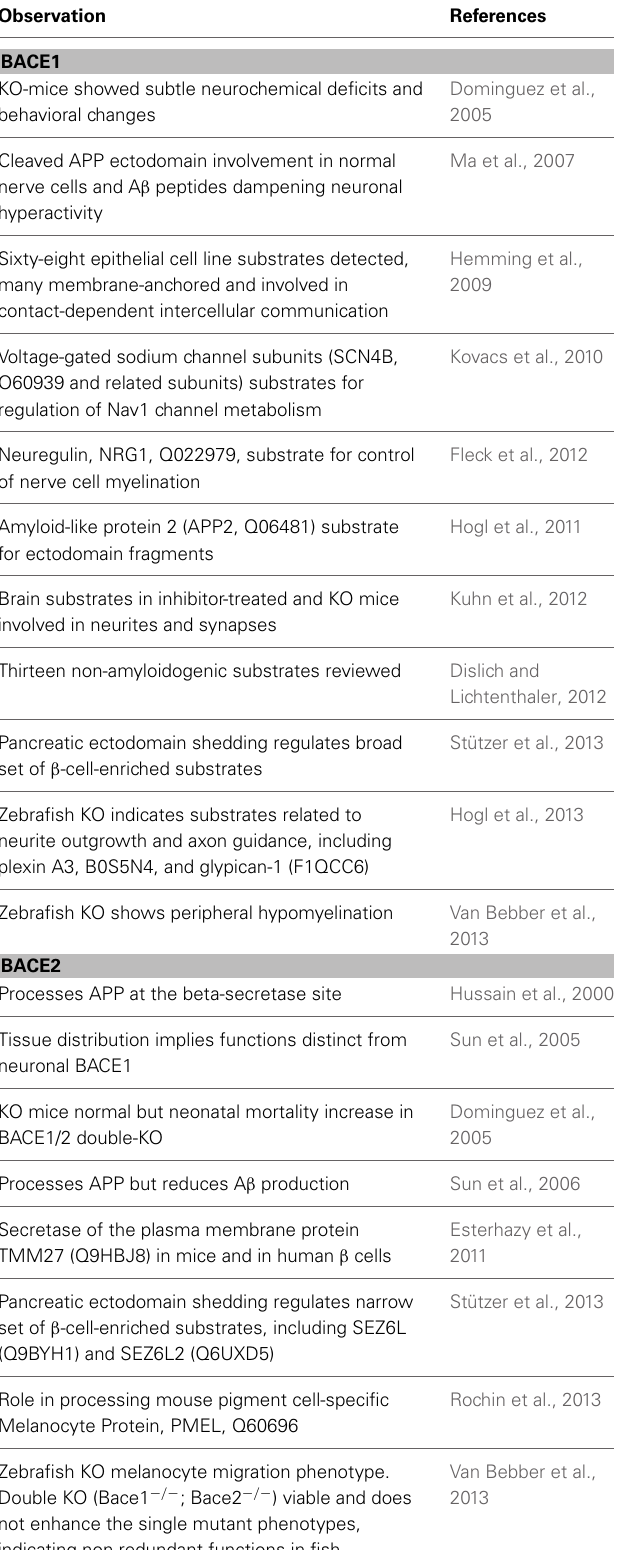
Table 1 | Summaries of findings related to normal functions of BACE1 (Upper section) and BACE2 (lower section) in chronological order (KO = gene